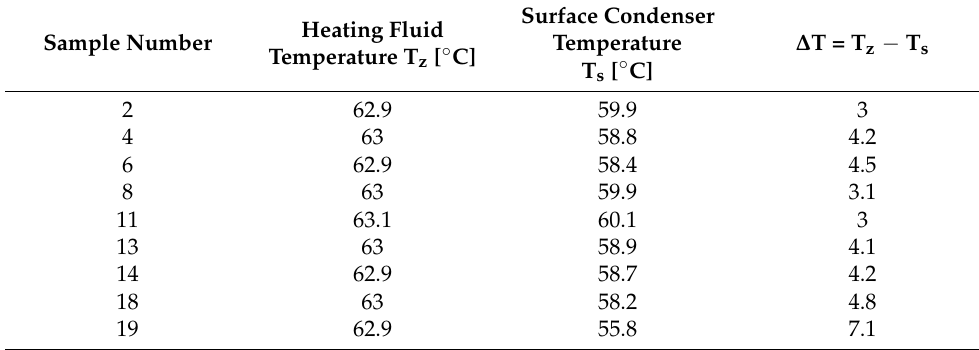
Table 5. The results of thermal energy transport test of heat pipes.